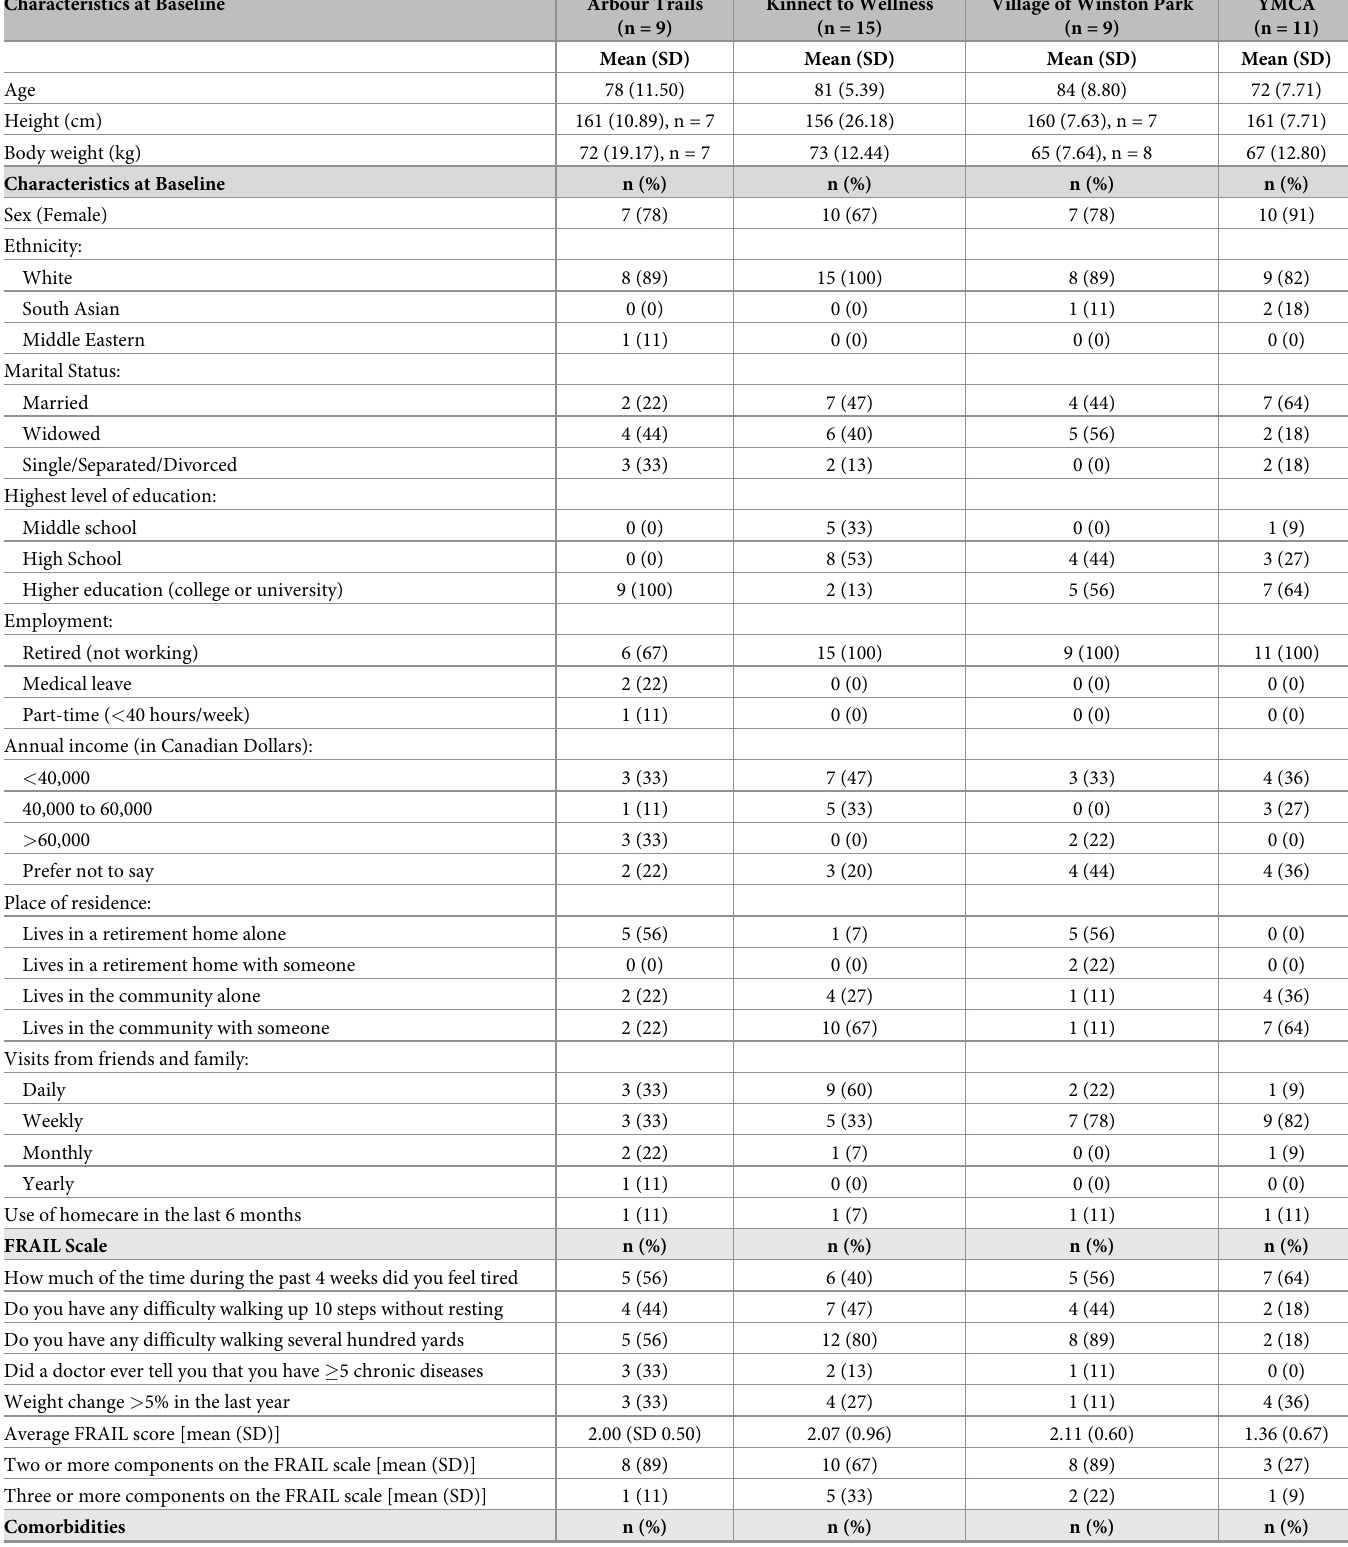
Table 2. Demographic and health status of trial participants at baseline (n = 44). Characteristics at